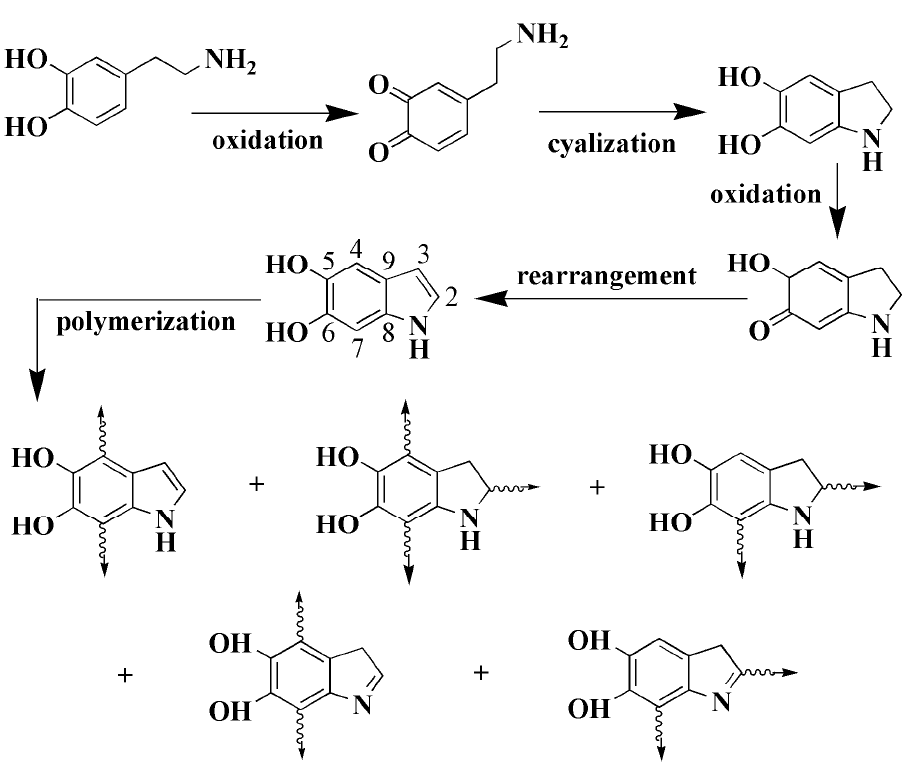
Scheme 1. Polymerization mechanism behind the formation of